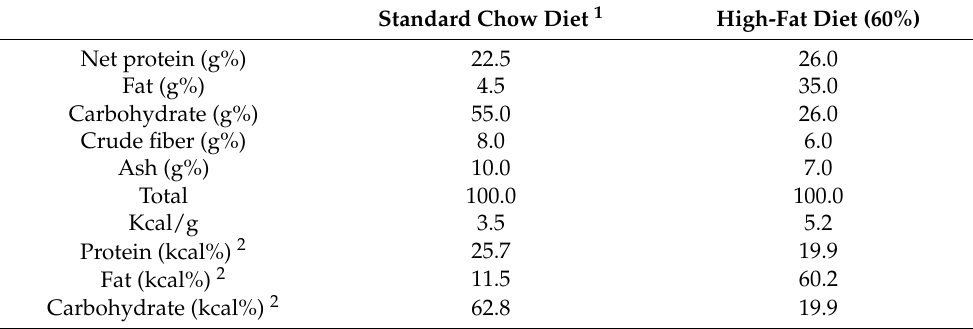
Table 1. Nutritional composition of the high-fat diet and standard chow